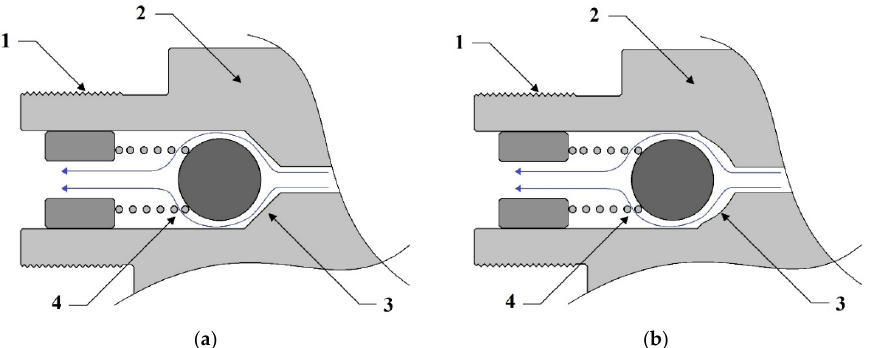
Figure 2. ( a ) Ball check valve with conical seat; 1—Connection to the high-pressure accumulator; 2—Hydraulic head body; 3—Conical seat; 4—Spring; ( b ) Ball check valve with spherical seat; 1—Connection to the high-pressure accumulator; 2—Hydraulic head body; 3—Spherical seat; 4—Spring.